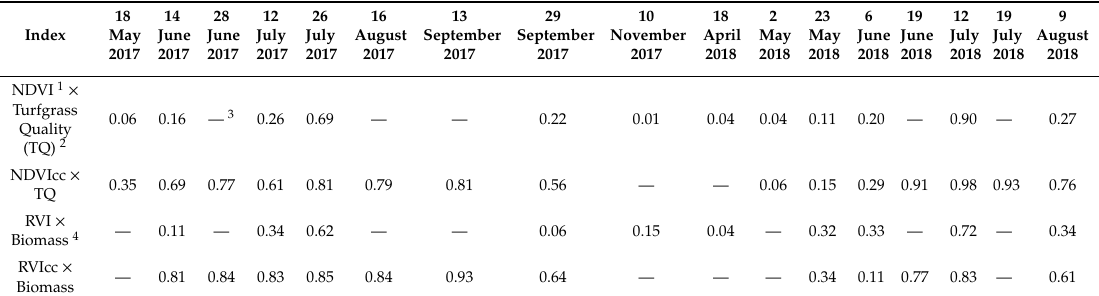
1 NDVI, normalized difference vegetation index; RVI, simple ratio vegetation index. Multispectral Crop Circle ACS ‐ 430 calculated indices represented by “cc”. Indices not denoted with “cc” were calculated by the hyperspectral radiometer; 2 Relationship between turfgrass quality (TQ) and NDVI and NDVIcc by date; 3 Dashes indicate measurement unable to be taken on that date; 4 Relationship between tall fescue biomass and RVI and RVIcc by date.